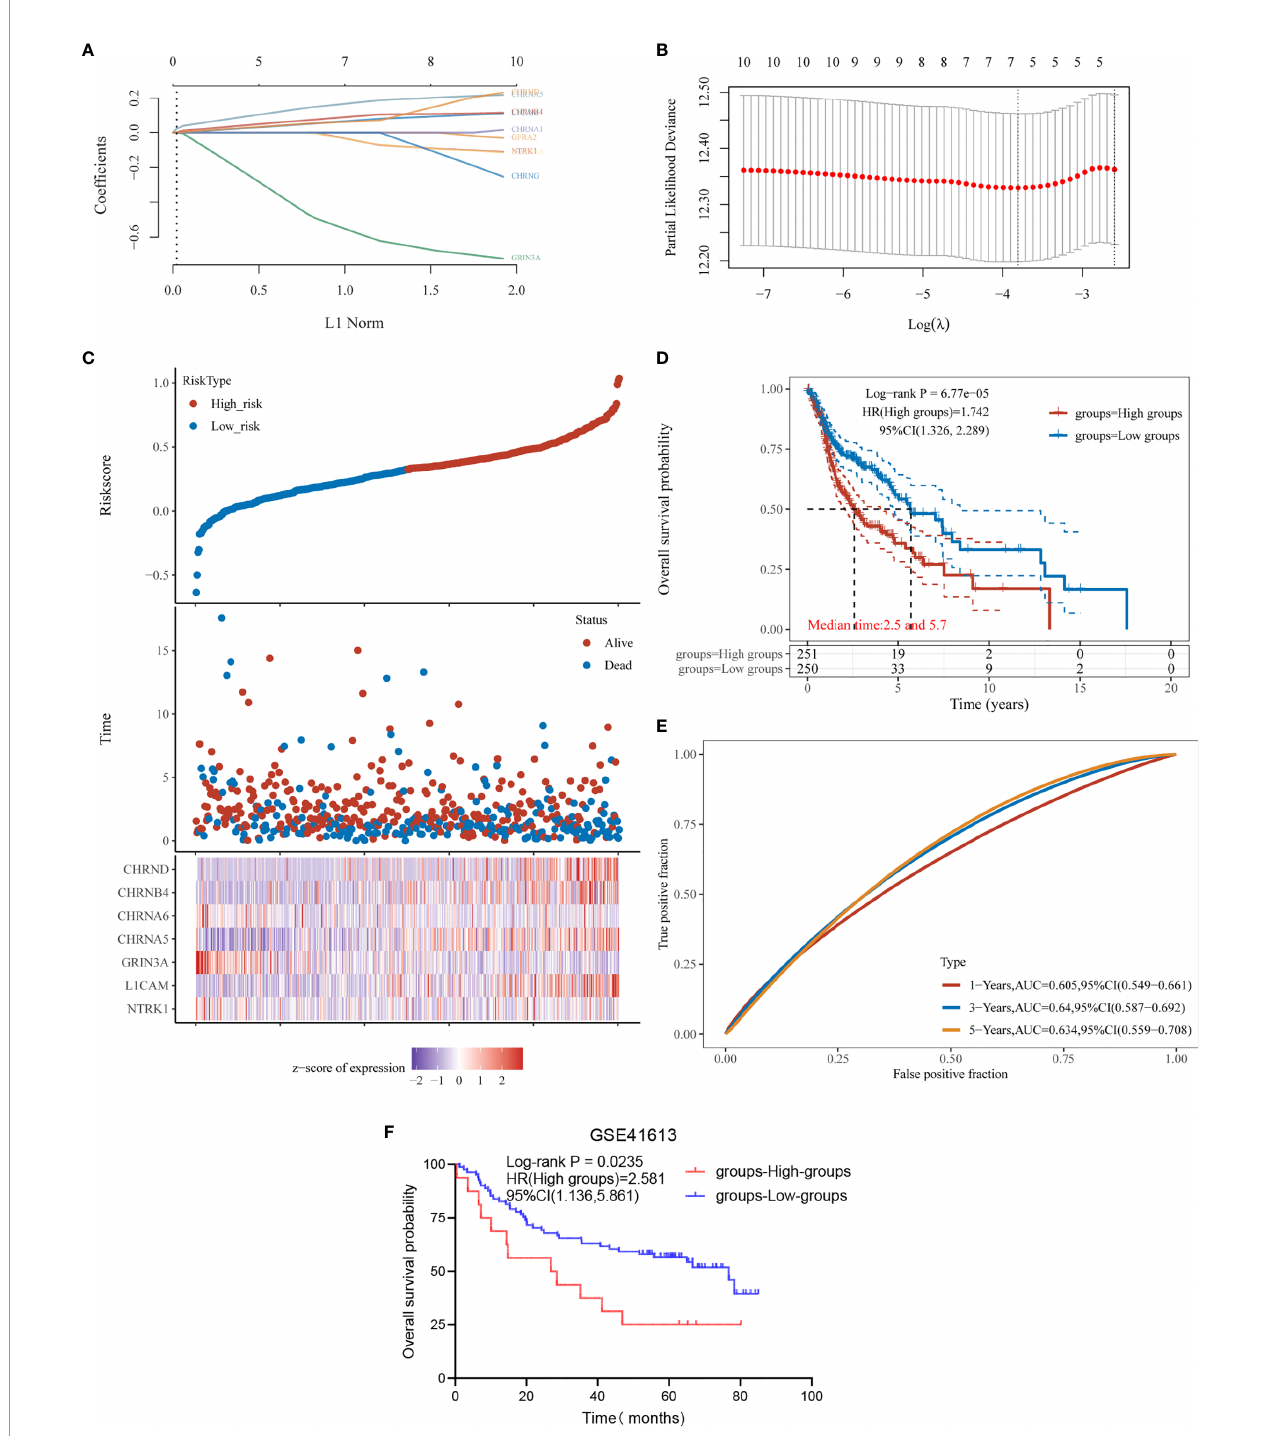
FIGURE 4 | Construction and veri fi cation of prognostic gene model. (A) LASSO coef fi cient pro fi les of the seven NCCGs. (B) Plots of the 10-fold cross-validation error rates. (C) Distribution of risk score, survival status, and the expression of seven NCCGs in HNSC. (D, E) Overall survival curves for HNSC patients in the high/ low-risk score group and the ROC curve of measuring the predictive value. (F) Overall survival rate for 97 HNSC patients of GSE41613 in the high/low-risk score groups. NCCGs, nerve-cancer cross-talk genes; HNSC, head and neck squamous cell